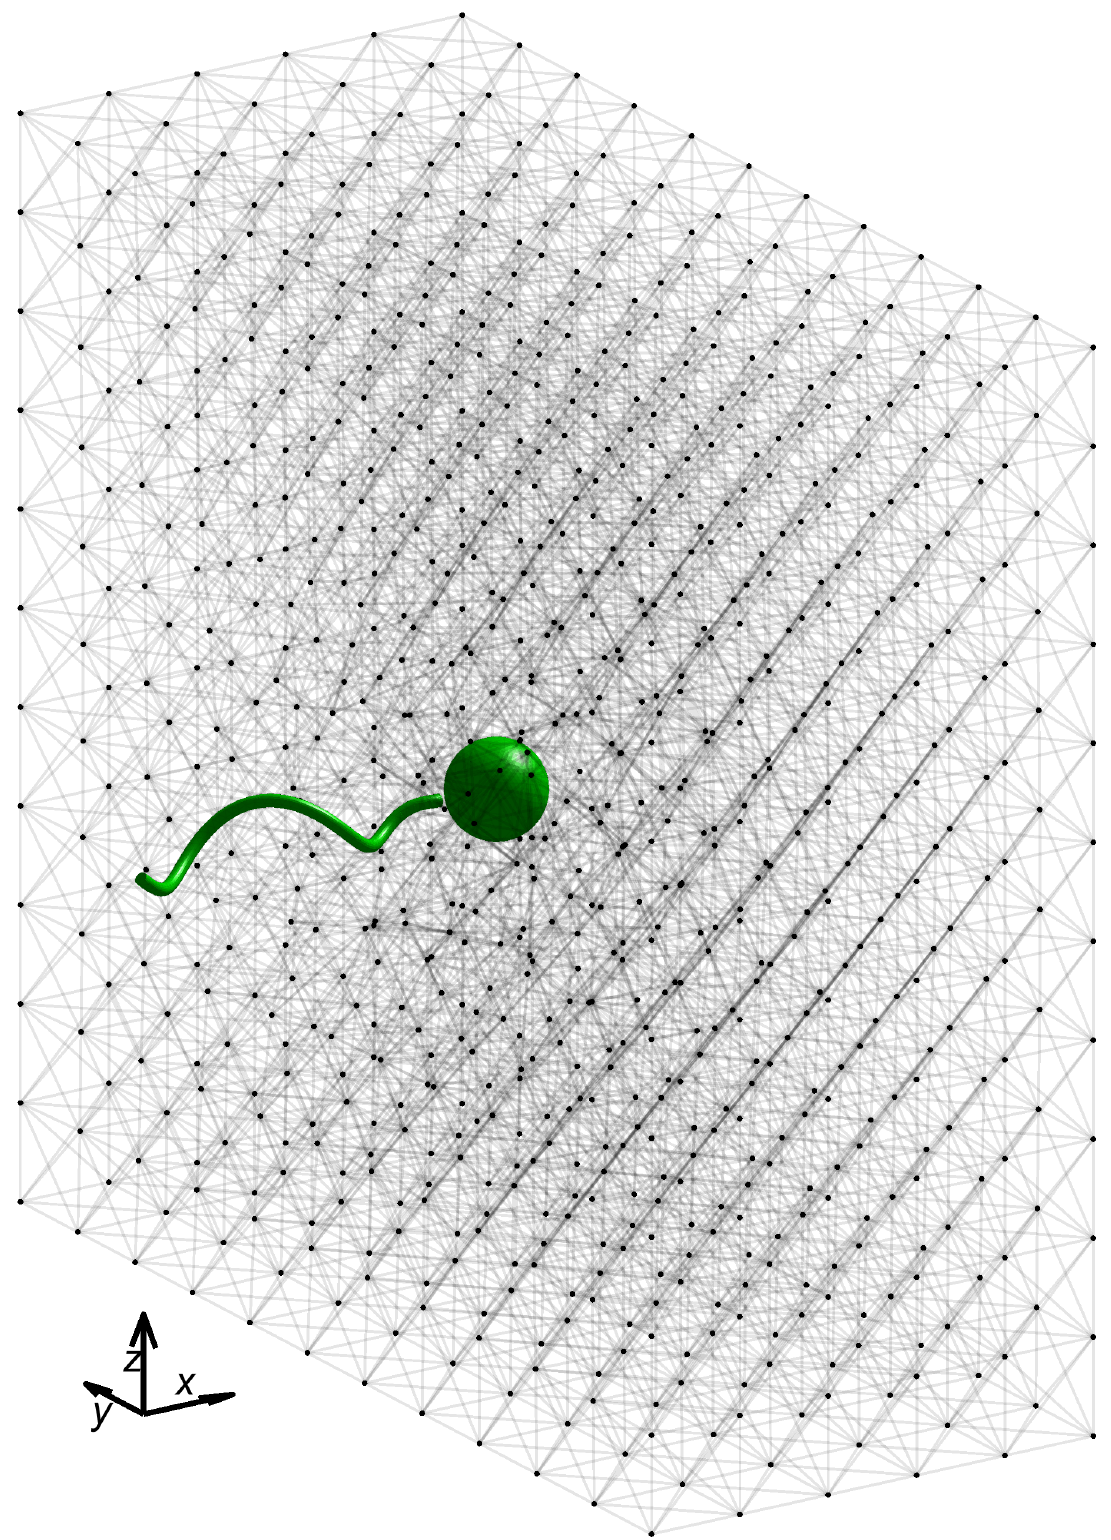
Figure 1. Snapshot of a model swimmer as it enters a viscoelastic network. Here, we choose a network that, in equilibrium, is a regular lattice where each interior node is connected to its six neighbors in the coordinate directions, as well as its twelve nearest diagonal